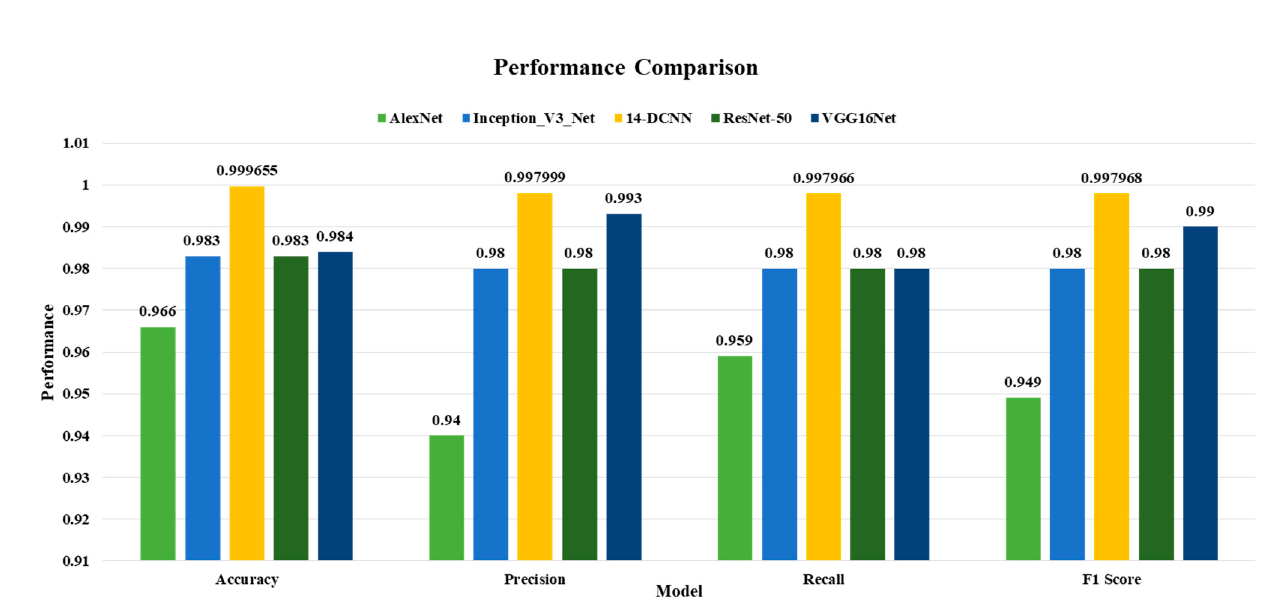
Figure 7. Performance comparison of proposed 14-DCNN and existing model.